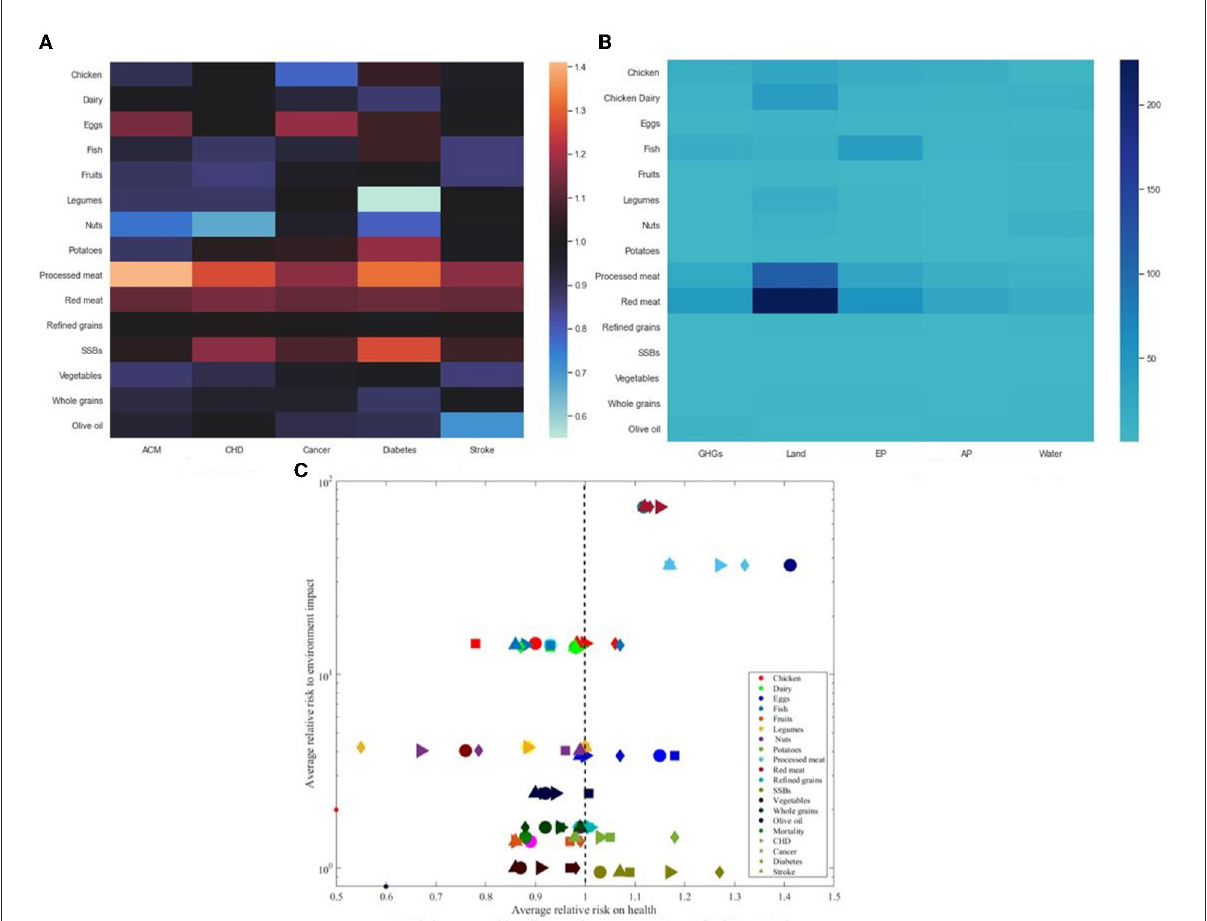
FIGURE7 Relative Risk to diseases and environmental impact of 15 highly consumed food groups. (A) Relative risk to disease for different food groups. (B) Relative risk to environmental damage for different food groups. (C) Relative average risk to disease and environmental impact for different food